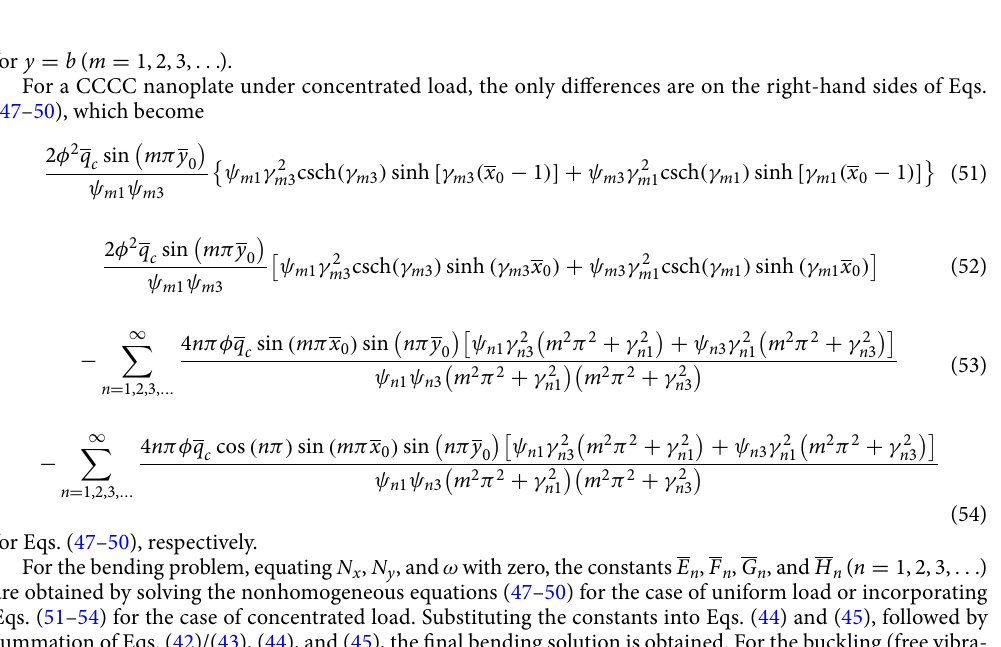
Table 3. Bending deflections, 10